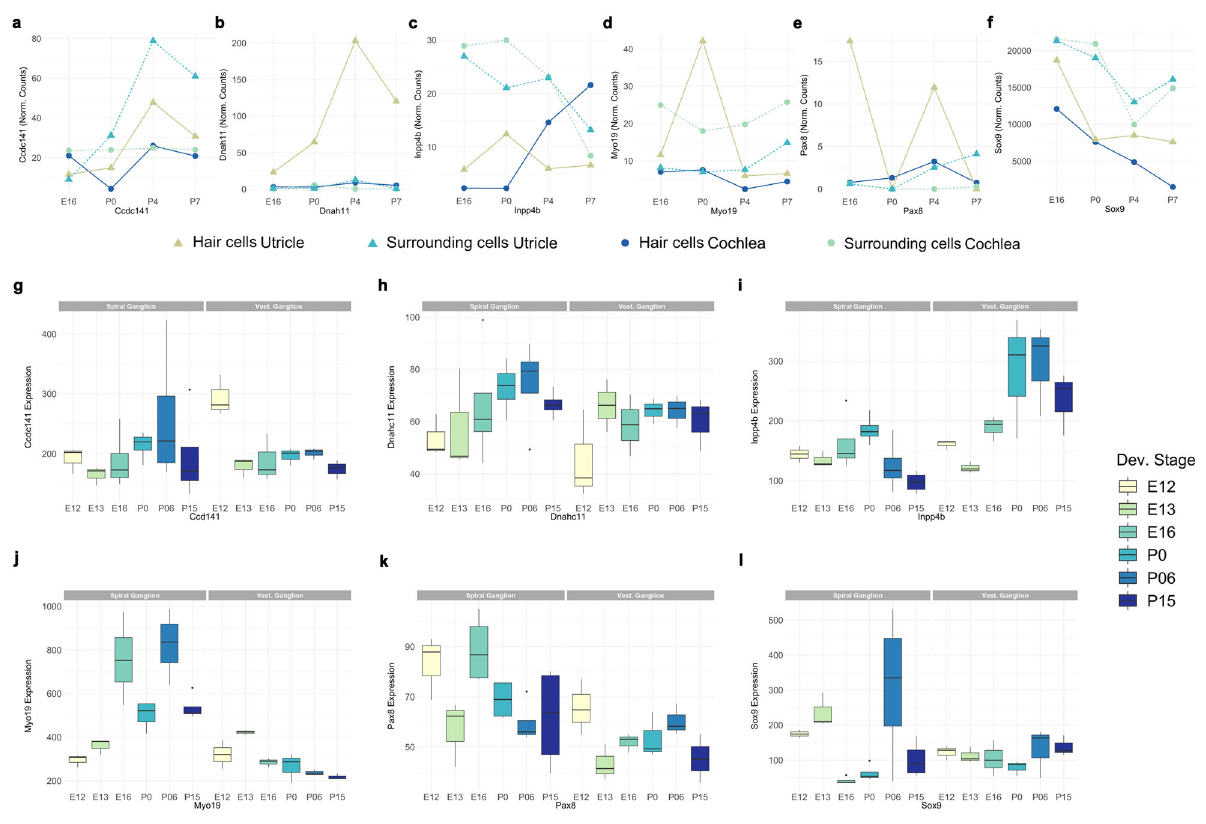
Fig. 4 Expression of novel candidate genes in the cochlea and utricle during mouse development. a – f RNA sequencing data of hair cells and surrounding cells from the cochleae and utricles of mice at four developmental stages: E16, P0, P4, and P7 are presented for the mouse orthologs of six novel candidate genes 104 : Ccdc141 ( a ), Dnah11 ( b ), Inpp4b ( c ), Myo19 ( d ), Pax8 ( e ), Sox9 ( f ). All genes show expression in the inner ear hair cells. Data are presented as normalized RNA-seq counts. g – l Expression of novel candidate genes in spiral and vestibular ganglion neurons of the inner ear during mouse development at six developmental stages: E12, E13, E16, P0, P06, and P15 105 . Expression is presented for Ccdc141 ( g ), Dnah11/ Dnahc11 ( h ), Inpp4b ( i ), Myo19 ( j ), Pax8 ( k ), and Sox9 ( l ) with all genes showing expression in the spiral and vestibular ganglion of the inner ear during development. Expression microarray data is presented by the perfect match and mismatch probe differences (PM/MM). Data for ( a – l ) were obtained from SHIELD (Shared Harvard Inner-Ear Laboratory